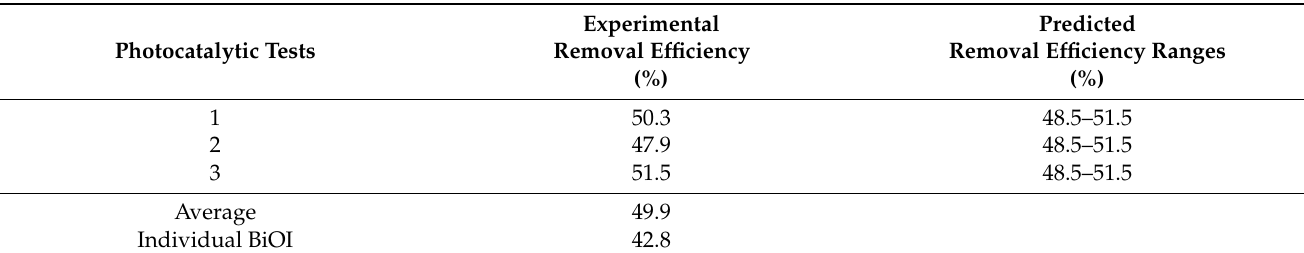
Table 2. Comparison of the photocatalytic activities of the BiOI/mordenite composite synthesized under the optimal experimental conditions (187 °C during 9 h) with pure BiOI.